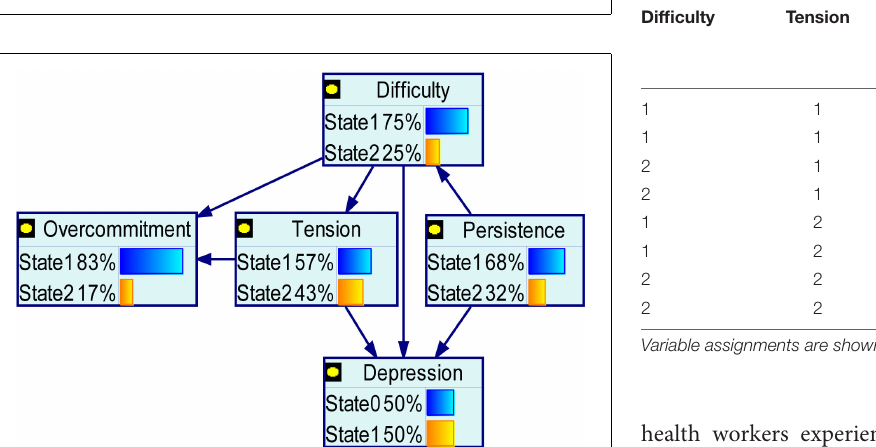
FIGURE 1 | Bayesian network for anxiety. Anxiety and the significant COVID-19-related variables in the multivariate analyses after propensity score matching entered into Bayesian network.